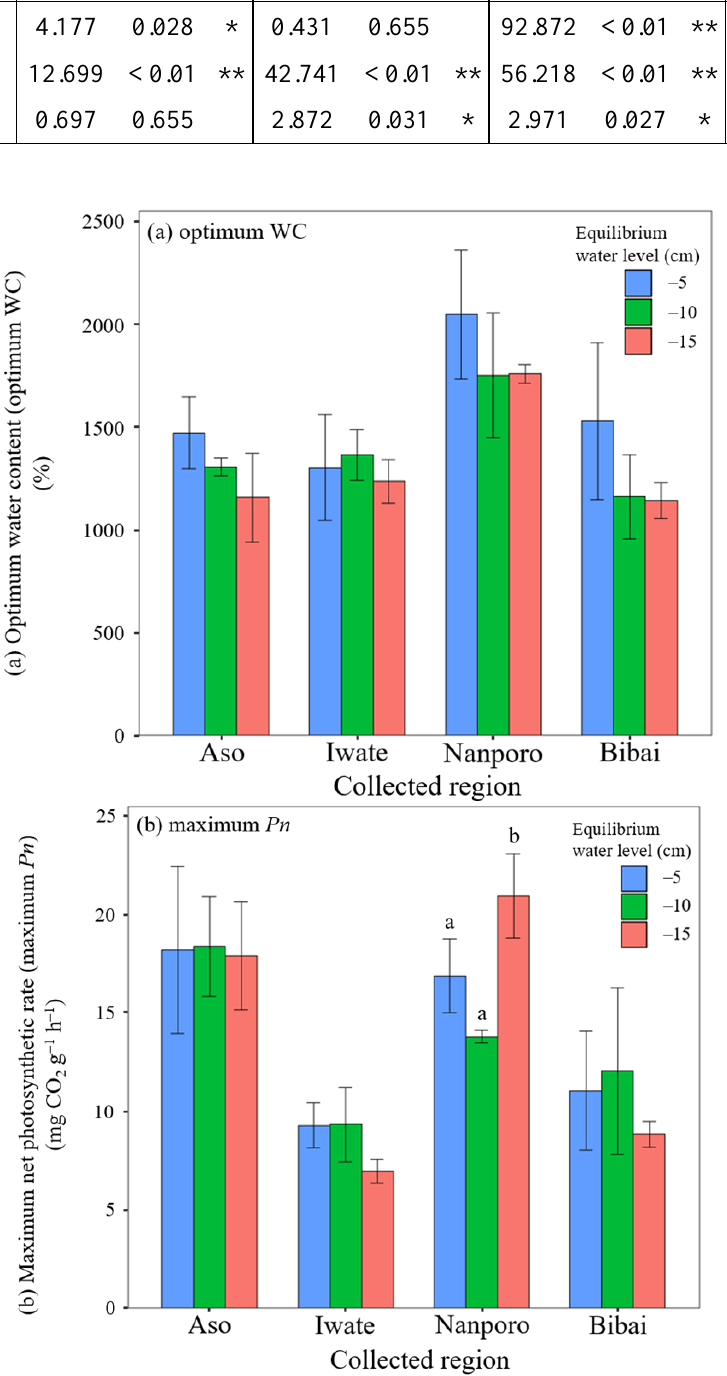
Figure 7. Comparison of (a) optimum water content (optimum WC) (%) and (b) maximum net photosynthetic rate (maximum Pn ) (mg CO g –1 h –1 ) of Sphagnum palustre from Aso, Iwate, Nanporo, and 2 Bibai. The error bars denote standard deviation ( n = 3), except for the sample from Bibai at -10 cm ( n =